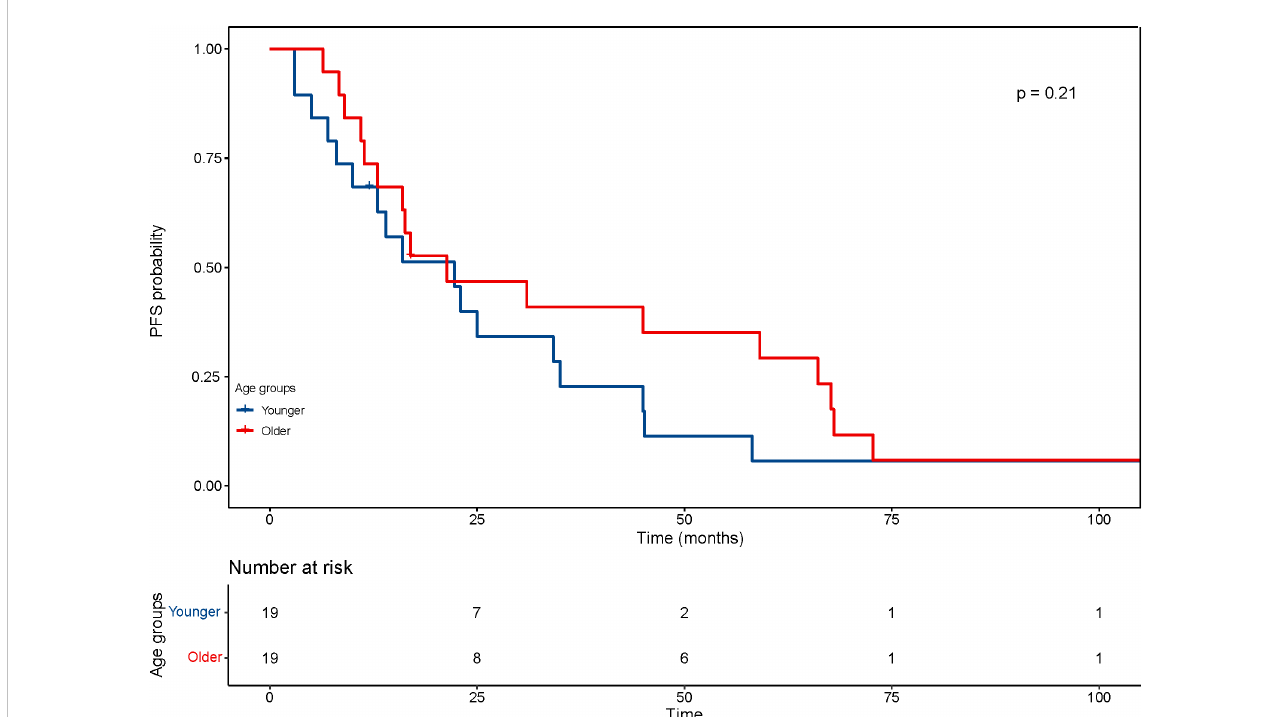
FIGURE 5 Kaplan – Meier curves for progression-free survival (PFS) of patients with small hepatocellular carcinomas after cryoablation. The log-rank test showed no signi fi cant difference between the four groups (P =0.21).